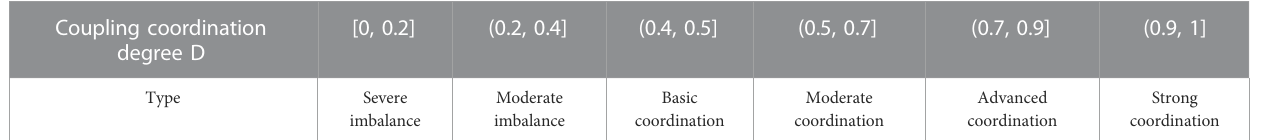
TABLE 3 The classi fi cation of coupling coordinating degree.